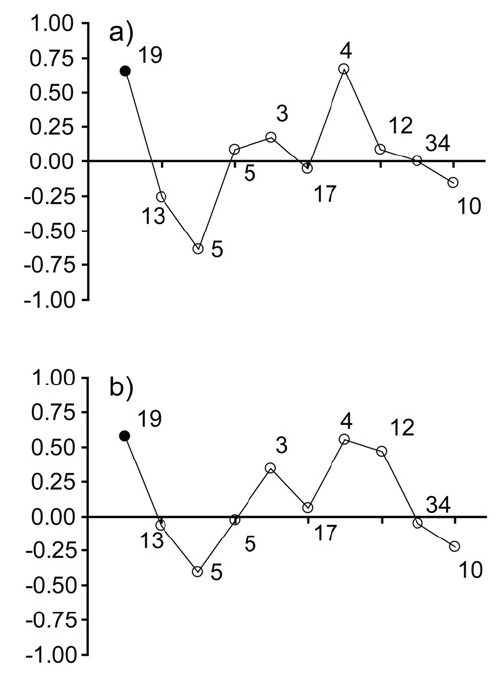
Fig. 2 . Moran’s I correlograms with global significance at the p < 0.05 level based on 1000 iterations. a) 2004 nest-site model ( sS + lS , model A1); b) 2004 nest-site and functional connectivity model ( sS + RPIm , model D1). Circled points had significant ( p < 0.05) spatial autocorrelation in that distance class. Numbers above the points refer to the number of pairs in each distance